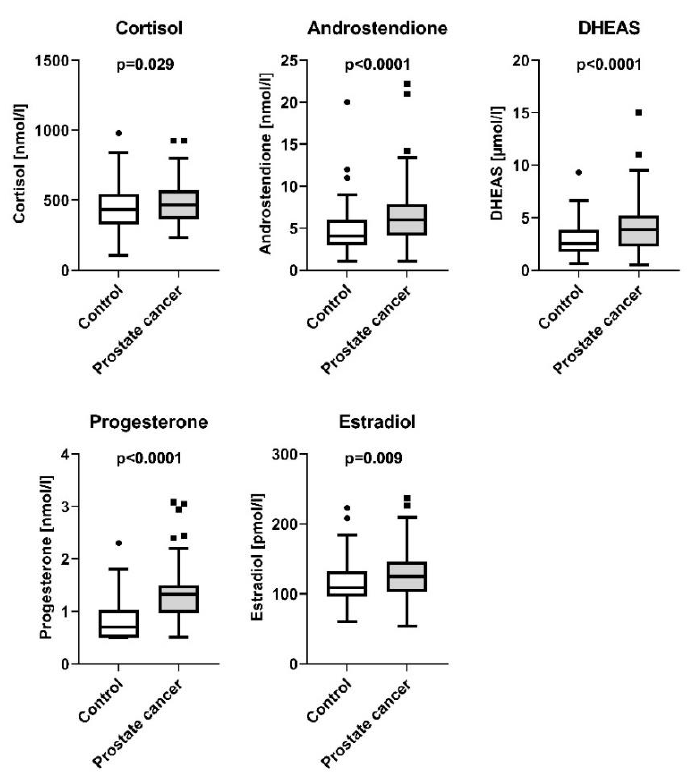
Figure 2. Steroid hormones in controls and patients with prostate cancer. Presented are box plots with whiskers indicating 1.5 interquartile range.